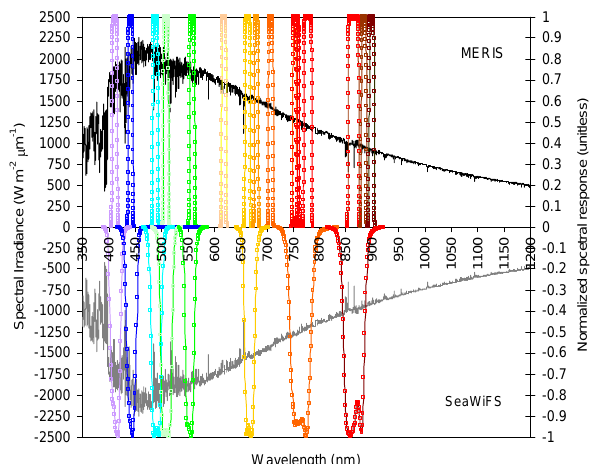
Fig. 2. The spectral response functions (unitless) of SeaWiFS and MERIS superimposed on the Thuillier 2004 irradiance spectrum (W m -2 µ m -1 ). To avoid overlapping of the spectral response functions of SeaWiFS and MERIS, each one is displayed on either side of this plot.